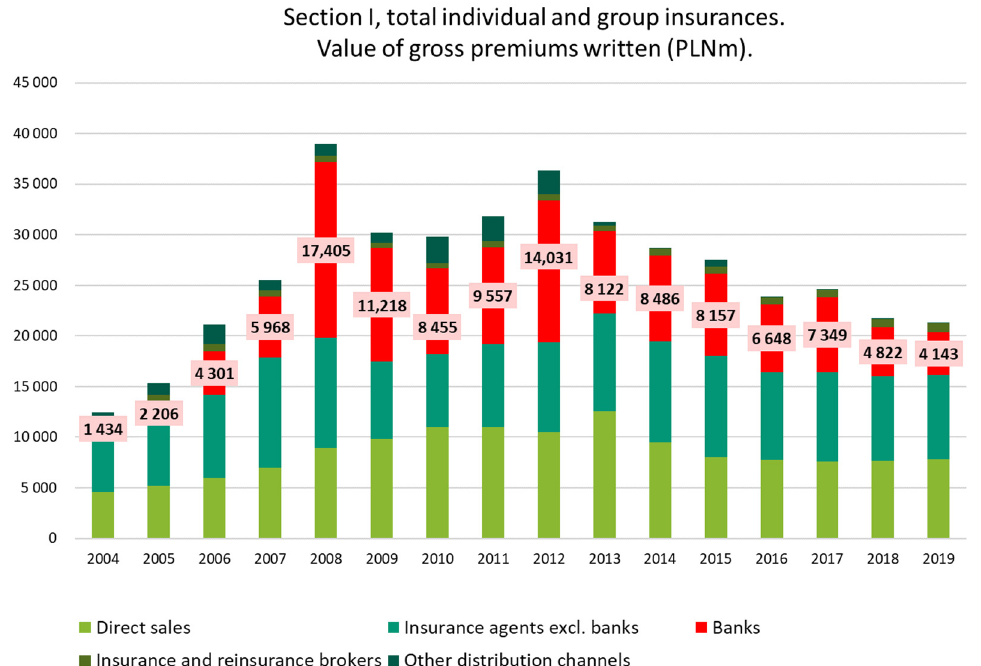
Figure 2. Value of gross premiums written in Section I, source: own study based on KNF’s data (Polish Financial Supervision Authority